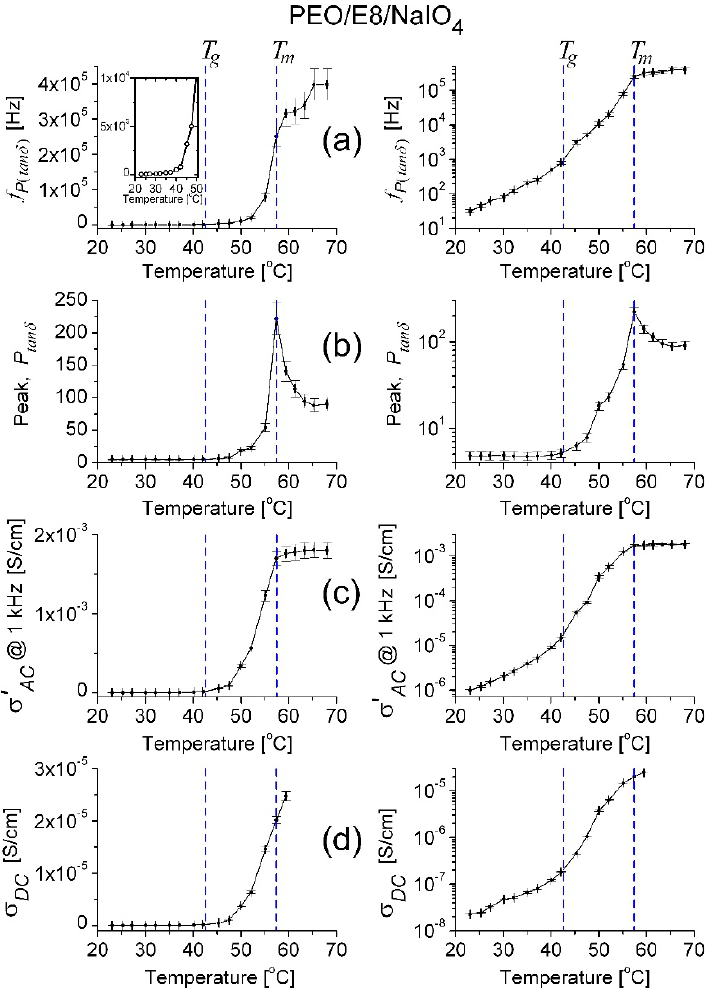
Figure 13. Temperature dependence of the peak frequency f P ( tanδ ) with the insert representing the enlarged part of the temperature dependence f P ( tanδ ) ( T ) ( a ) , and the peak values P tanδ ( b ) and σ (cid:48) ( c ) at f = 1 kHz determined for PEO/E8/NaIO 4 composite, in linear ( left ) and logarithmic ( right ) scale. The temperature dependence of ion conductivity ( σ ) for PEO/E8 is given for comparison ( d ). The dashed lines point out the values of glass transition temperatures ( T g ) for both composites. The error bars indicate the uncertainty of the calculated